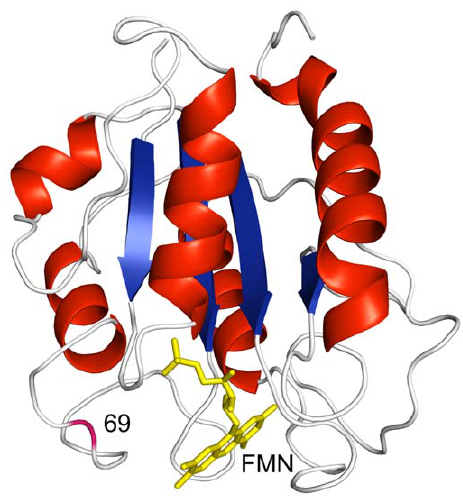
Figure 2. Cartoon drawing of the X-ray structure of flavodoxin from A.vinelandii . a -Helices are shown in red, b -strands in blue and loops in white. The FMN cofactor is coloured yellow and the backbone of residue 69 is coloured magenta. Note that this residue is in immediate vicinity of FMN. The X-ray structure is of the C69A variant of the protein (pdb ID 1YOB) [30], in which the single cysteine at position 69 is replaced by alanine. This protein variant is largely similar to flavodoxin regarding both redox potential of holoprotein and stability of apoprotein [42,54].